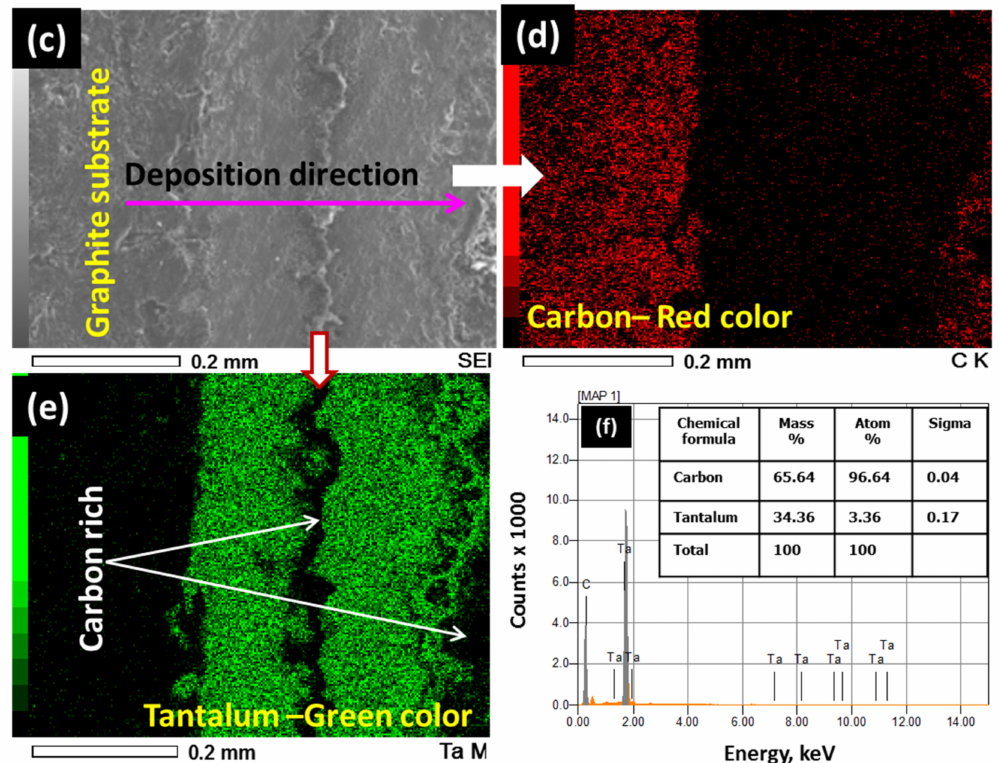
Figure 3. EDAX mapping and composition analysis of as-deposited coating across the thickness: ( a ) medium magnificantion TaC coating cross-section; ( b ) chemical composition mapping through color of Figure 3a; ( c ) low magnificantion SEM image of cross-section of the coating; ( d ) carbon composition mapping through color of Figure 3c; ( e ) tantalum composition mapping through color of Figure 3c; ( e ) area EDAX spectra of Figure